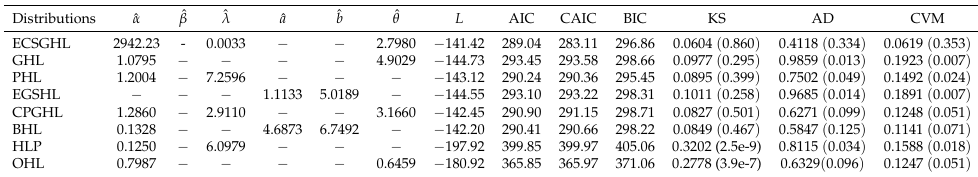
Figure 15. TTT plot for real data II. Table 4. Maximum likelihood estimates, L, AIC, CAIC, BIC, KS, AD, CVM with p -value in parenthesis for real data